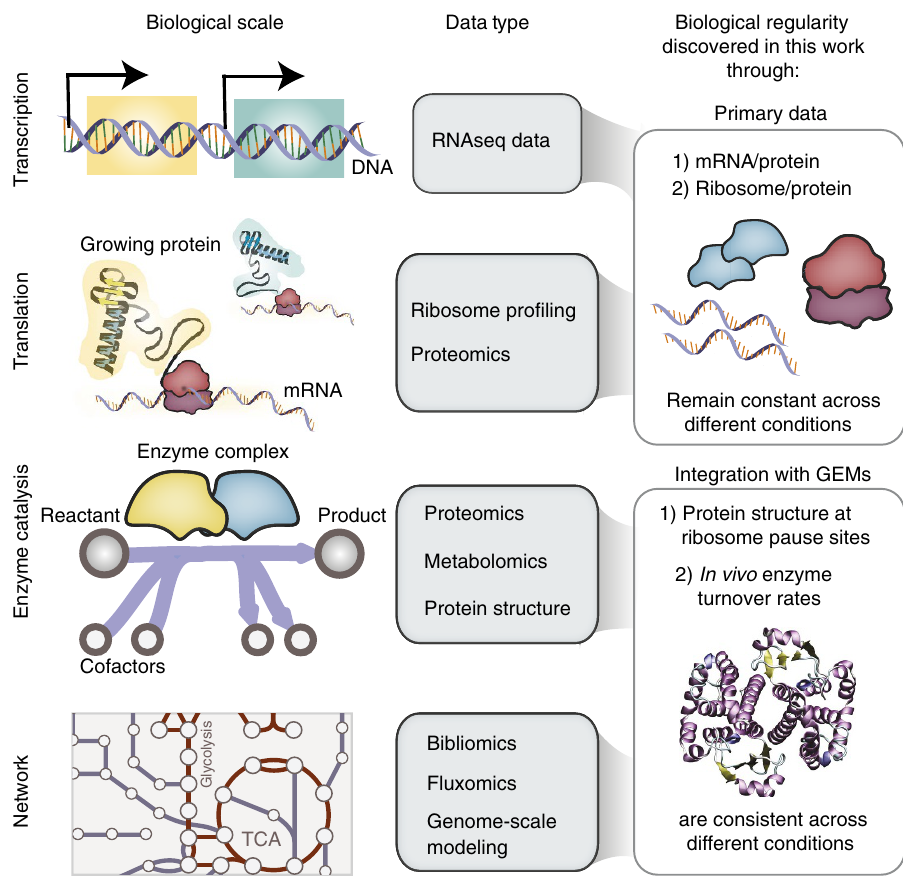
Figure 1 | A multi-scale multi-omics framework detects significant biological regularities in E. coli . Tracing the central dogma of biology (left column), we can link specific data types (middle column) to explain each of these biological processes. In this work, novel biological regularities that relate these processes are discovered through: (i) primary omics data (top box, right column) and (ii) integration with GEMs (bottom box, right